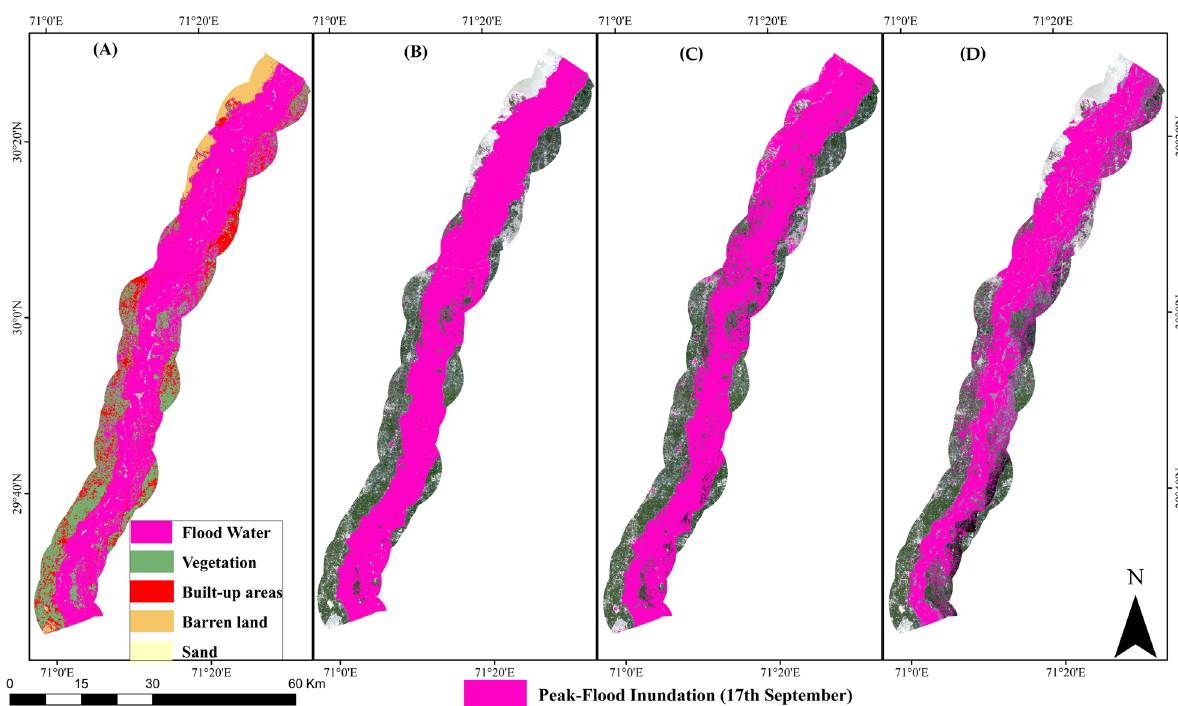
Fig. 8 A. comparison of Peak-Flood-2014 Inundation using A Supervised Classification B MNDWI C NDWI and D WRI